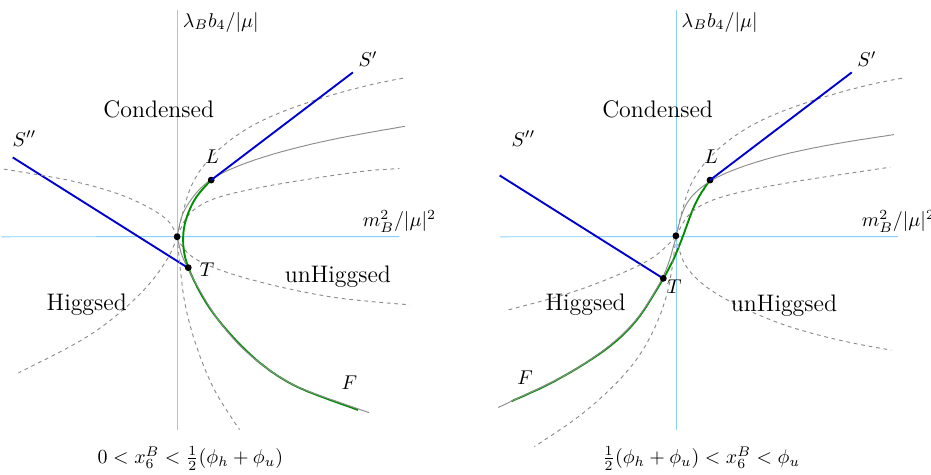
Figure 19 . Foliating parabolas for the range 0 < x B